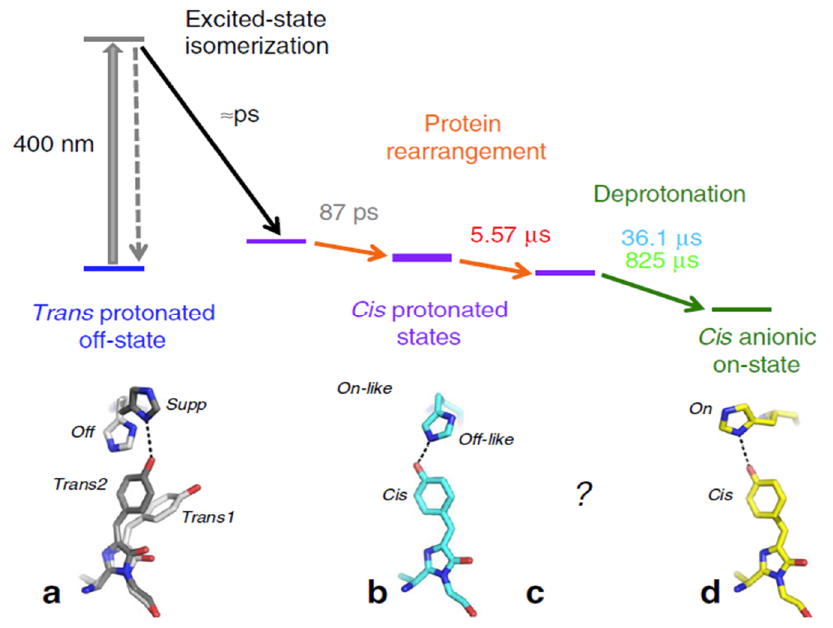
Figure 14. Model for the rsEGFP2 off-to-on photoswitching process. Figure reproduced with permission from Woodhouse et al. [ 124]. Copyright (2020) Springer Nature.